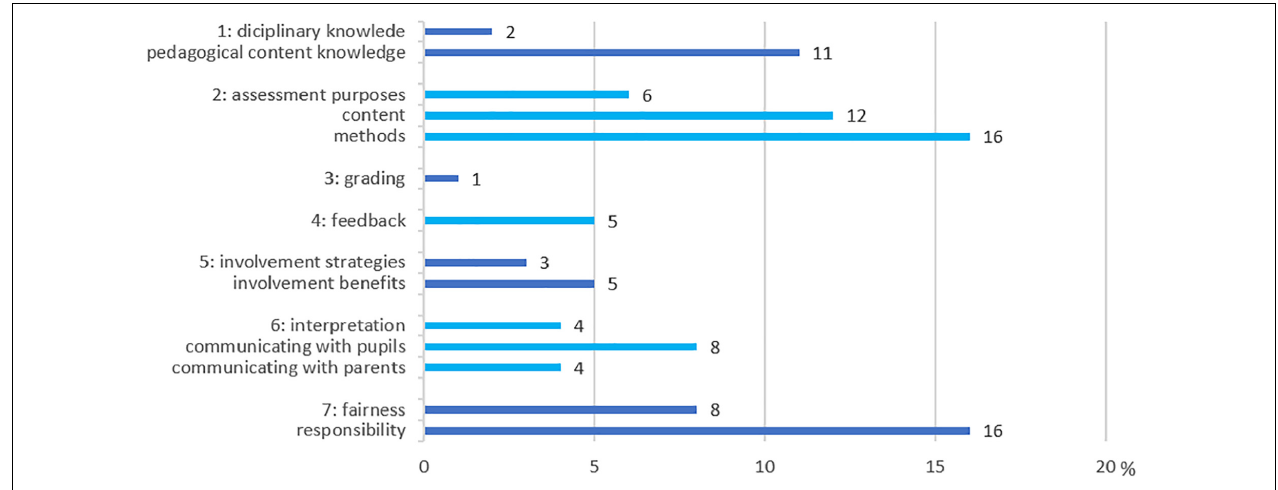
FIGURE 2 | Preservice teachers’ reflections on assessment knowledge base (different colors indicate the bar groups per element).